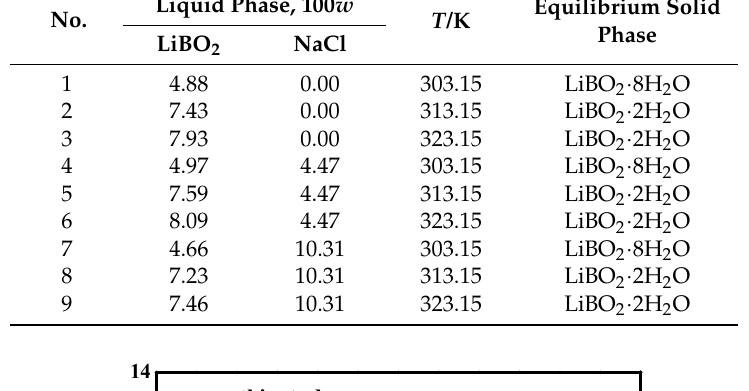
Equilibrium Solid T /K